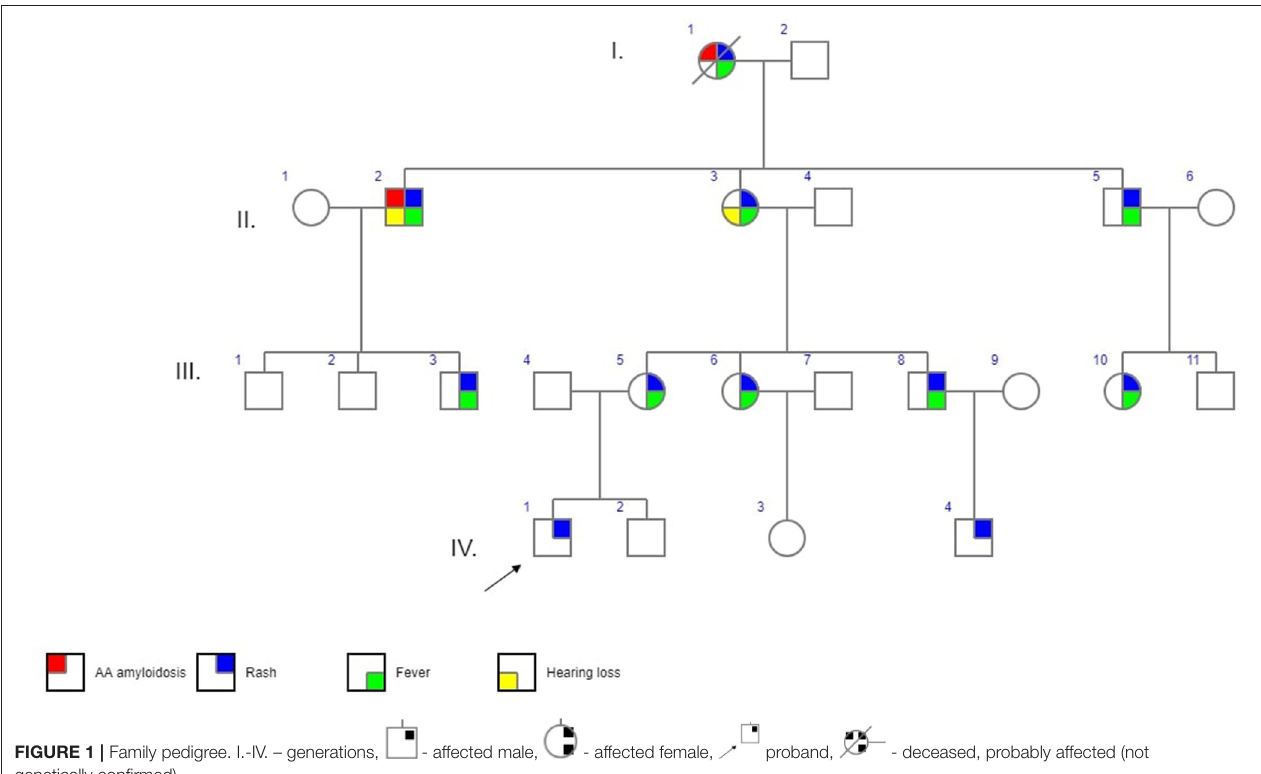
FIGURE 1 | Family pedigree. I.-IV. – generations, - affected male, - affected female, proband, - deceased, probably affected (not genetically